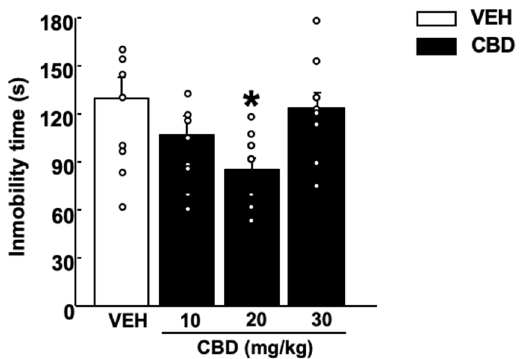
Figure 2. Effects of a single administration of cannabidiol (CBD) (10, 20 and 30 mg/kg, i.p.) on coping behaviors in the tail suspension test paradigm. The behavioral evaluation was developed 1 h and 30 min after the administration of CBD (or vehicle (VEH)). Columns represent the means and vertical lines ± SEM of immobility time (s). * Values from CBD-20 mg/kg-treated mice that were different ( p < 0.05) from VEH-treated group (one-way ANOVA followed by Student–Newman–Keuls test, p < 0.05).